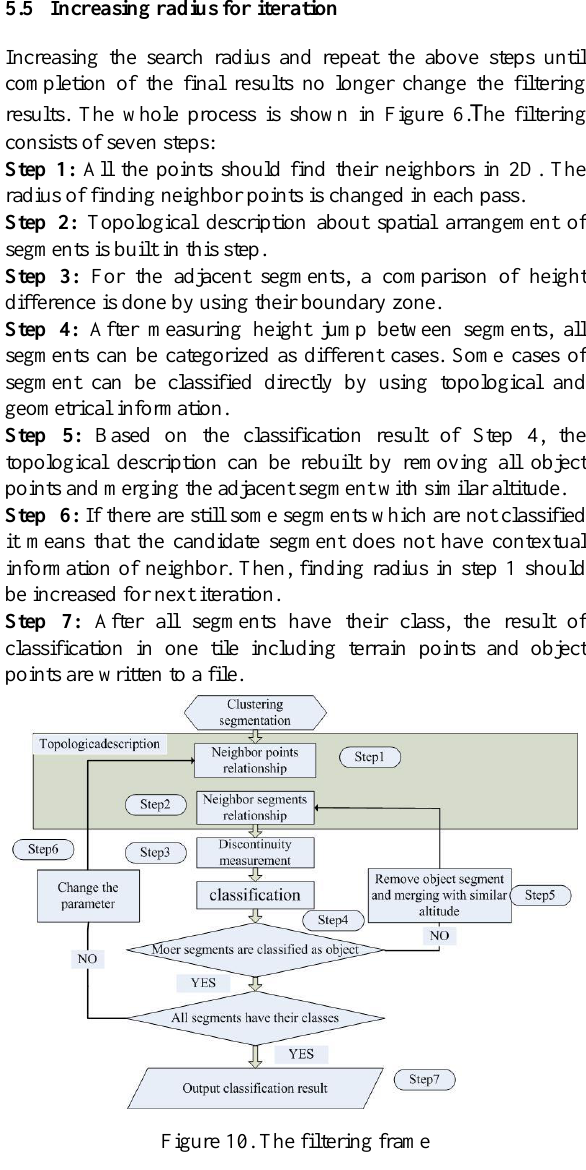
Figure 8. Measuring height difference in profile view